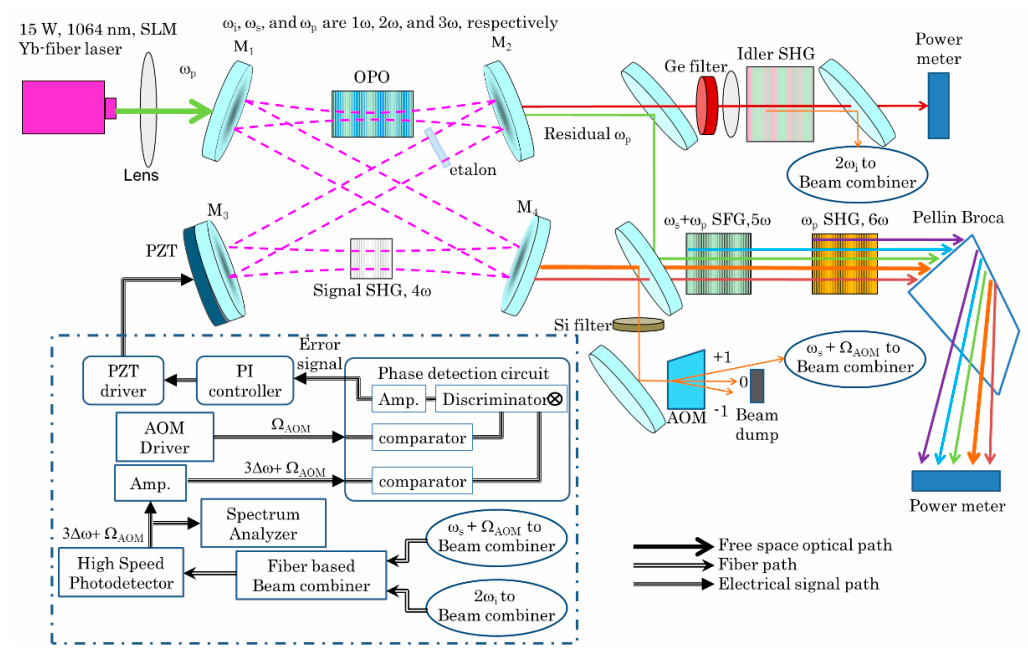
Figure 1. Multi-harmonic optical comb based on a frequency division-by-three singly resonant optical parametric oscillator. The optical parametric oscillator generates the fundamental wave (idler), the 2nd harmonic wave (signal), and the 3rd harmonic wave (pump) of the multi-harmonic optical comb. The 4th harmonic to 6th harmonic are generated by intracavity second harmonic generation (SHG), external cavity single-pass sum frequency generation (SFG), and external cavity single-pass SHG, respectively. The idler (the fundamental wave) SHG and a small portion of the 2nd harmonic wave are combined to produce an error signal for frequency control by tweaking the cavity length that is based on a home-made phase detection circuit, a commercial high-speed proportional integrating (PI) controller (New Focus LB1005) and a high voltage PZT driver (Physik Instruments E-501.621) shown inside the dashed